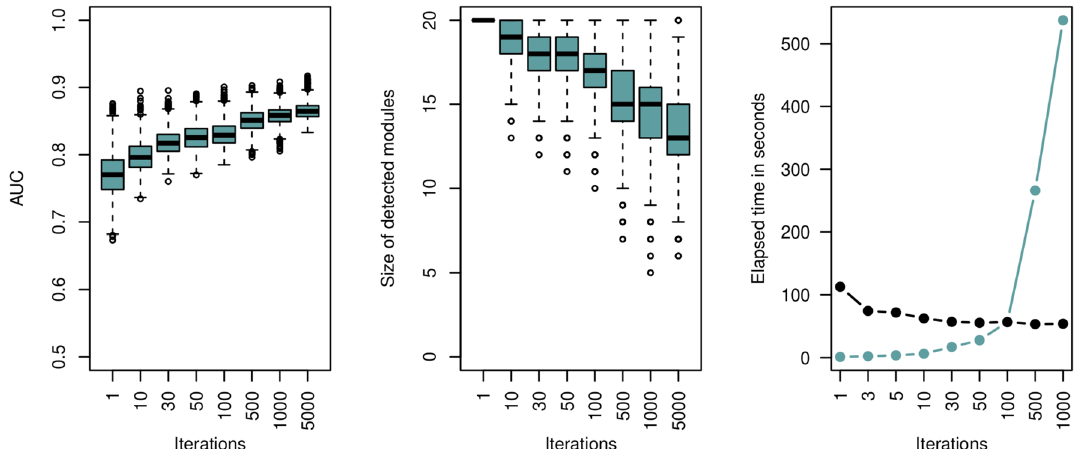
Figure 5. Disease module detection for kidney cancer survival prediction. Shown is the out-of-bag accuracy of the detected modules while varying the number of iterations (left panel). The second figure reports on the size of the detected modules. The computational demand of our proposed method is shown in the right panel. The blue line reflects the absolute computational cost in seconds, the black line is the computational cost divided by the number of greedy iterations.